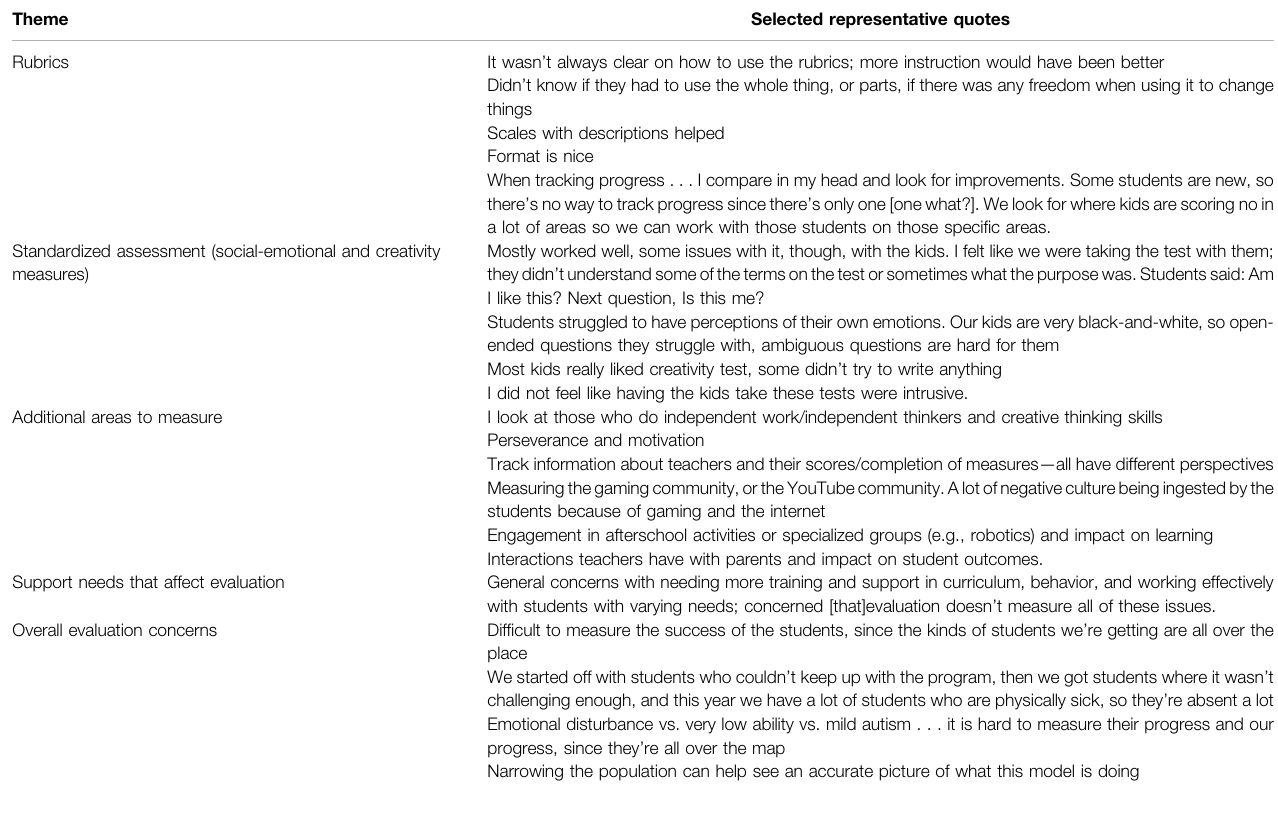
TABLE 5 | Themes from teacher focus group on STEM school